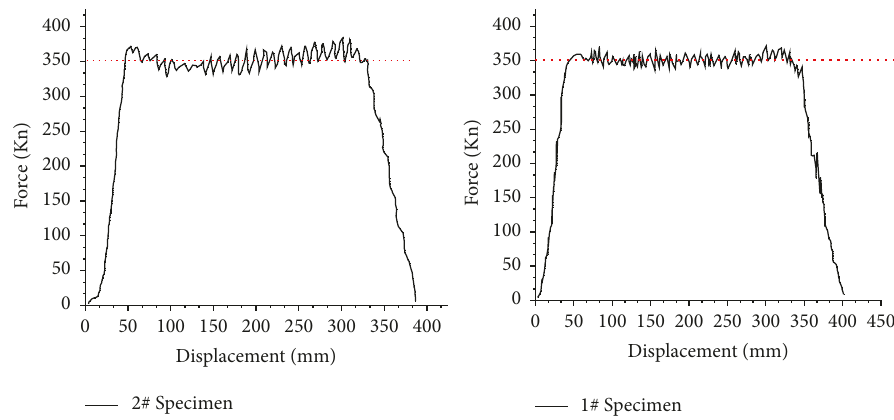
Figure 13: Static test system of NPR